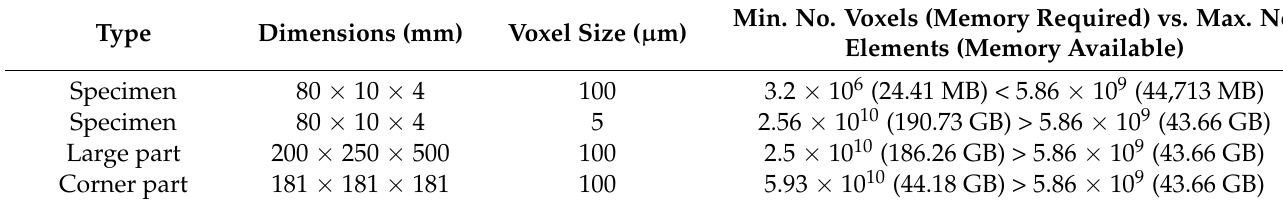
Table 7. Number of voxels according to dimensions and set voxel size.